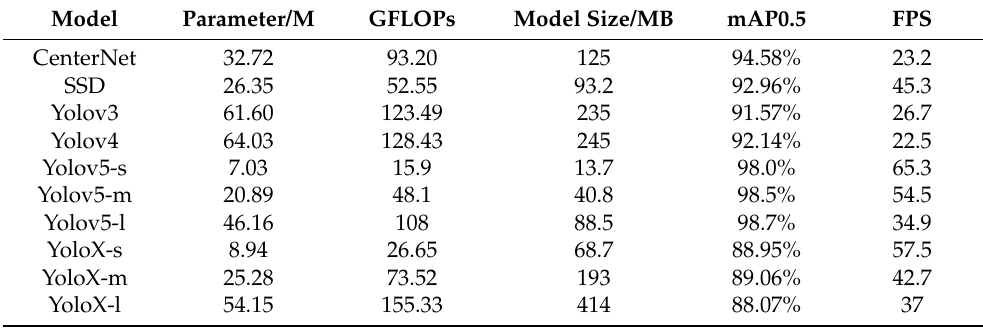
Table 2. Performance of multiple target detection networks in non-coal foreign objects